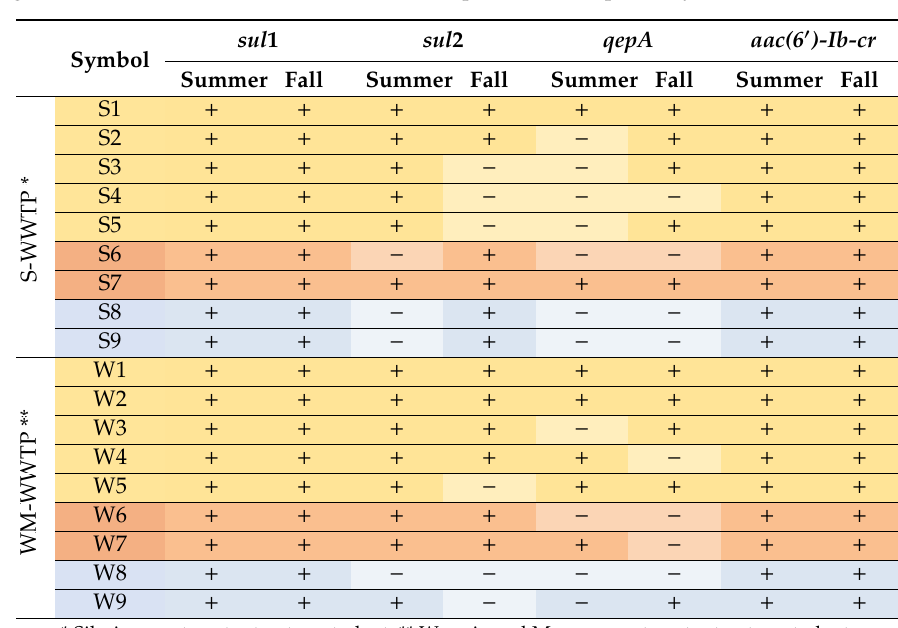
Table 3. Presence of amplicons for genes encoding resistance to sulfonamides and fluoroquinolones in the analyzed samples. Colors correspond to sampling sites as in Table 1. + and − denote amplicons for each gene that were and were not detected via endpoint PCR,